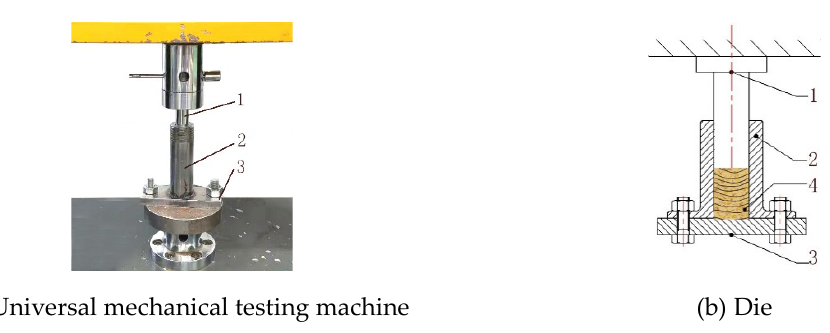
Figure 2. The schematic diagram of compaction apparatus: 1-Compressive bar; 2-Die sleeve; 3-Pedestal; 4-Biomass raw material.